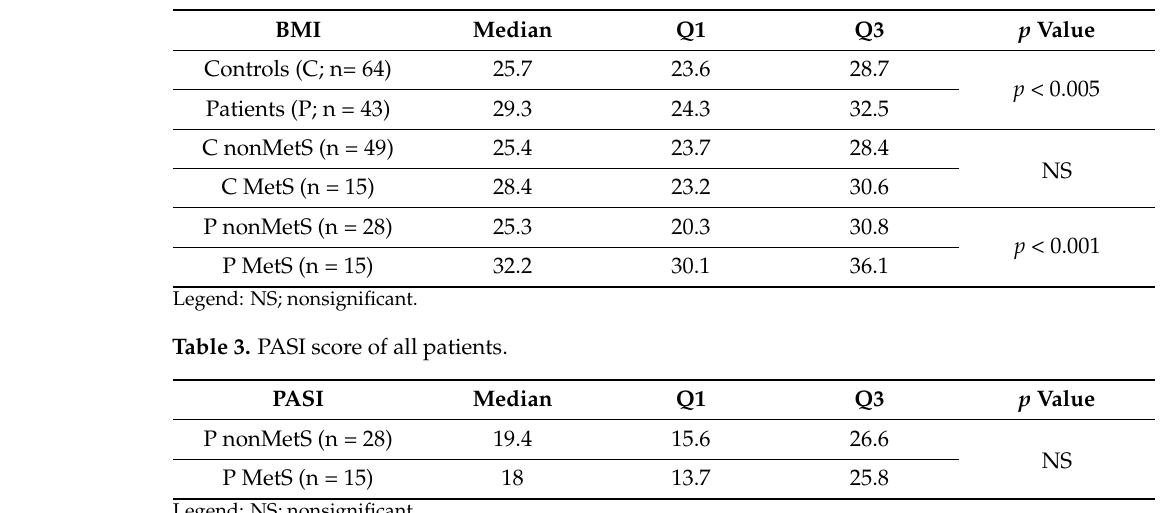
Table 2. BMI of all participants.